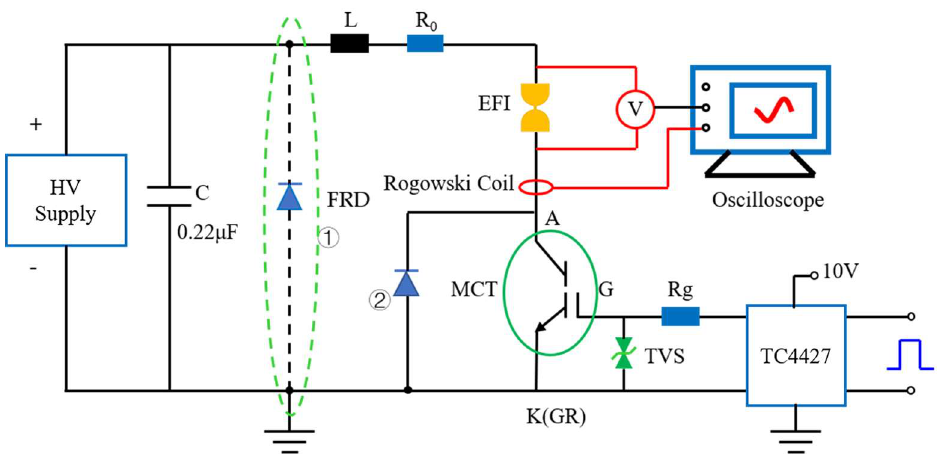
Figure 3. Schematic diagram of the CDU used to do the electric performance test and initiation test.